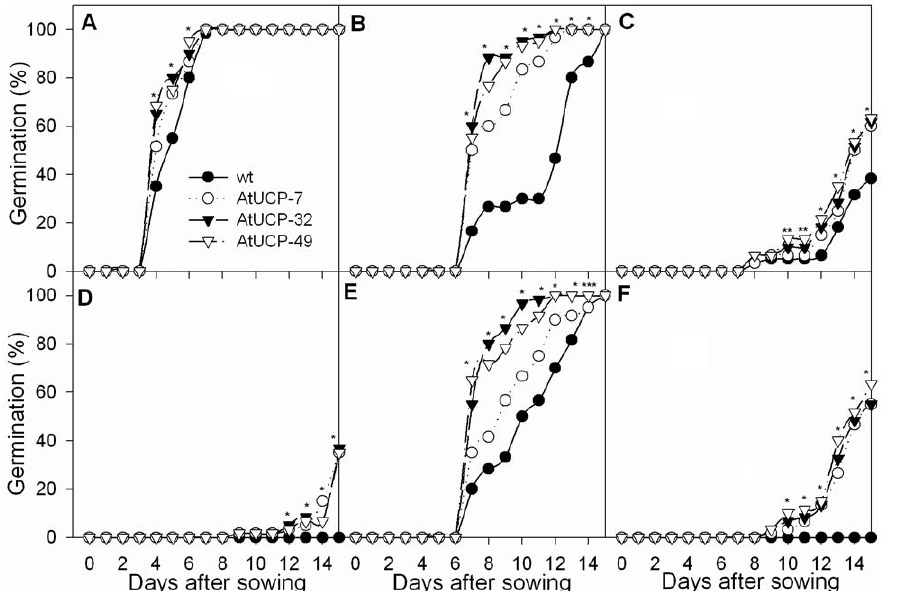
Figure 1. Seed germination under drought and salt stresses. Seeds from wild-type (WT) and AtUCP1 transgenic lines (7, 32 and 49) were cultivated in medium containing different concentrations of mannitol and NaCl to induce drought and salt stresses, respectively. (A) control; (B) 200 mM mannitol; (C) 300 mM mannitol; (D) 400 mM mannitol; (E) 100 mM NaCl; and (F) 175 mM NaCl. *, ** and *** indicate significant differences relative to the controls at P , 0.0001, P , 0.001 and P , 0.01, respectively. The values are means of 3 independent replications (each with 30